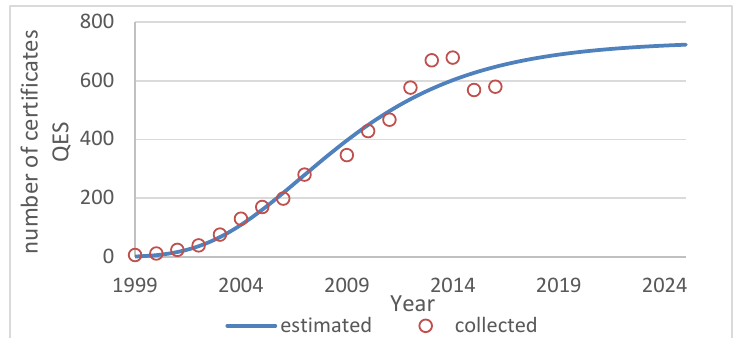
Figure 6. Updated Gompertz curve (Portugal)